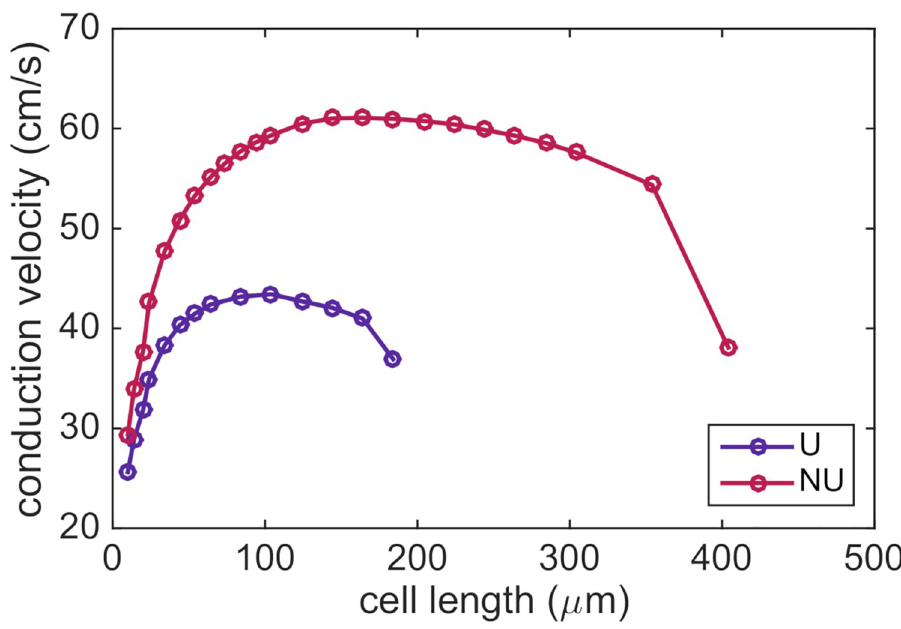
Fig 13. Conduction velocity as a function of cell length when the number of sodium channels per cell remains constant. The cell length here refers to the total length of O O , O W and O E (see Fig 2), but only the length of O O is varied in the simulations. The remaining parameter values are given in Table 1, except that for cell lengths shorter than 20 μ m, the length of O N and O S in the x -direction is reduced to the cell length minus 6 μ m so that they fit on O O . For the simulations of cell lengths of up to 104 μ m, the simulation includes 20 cells, the first four cells are stimulated and the conduction velocity is calculated between cells number seven and thirteen. For the remaining cell lengths, the simulation includes ten cells, the first two cells are stimulated and the conduction velocity is computed between cells number three and seven.